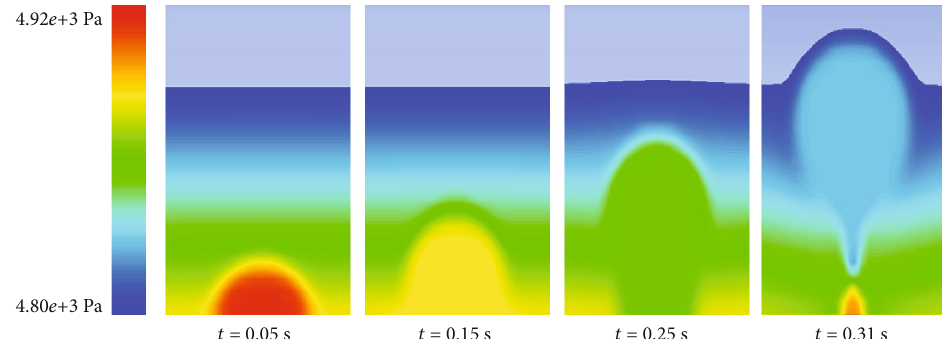
Figure 5: Cloud diagram of the pressure distribution for bubble formation and